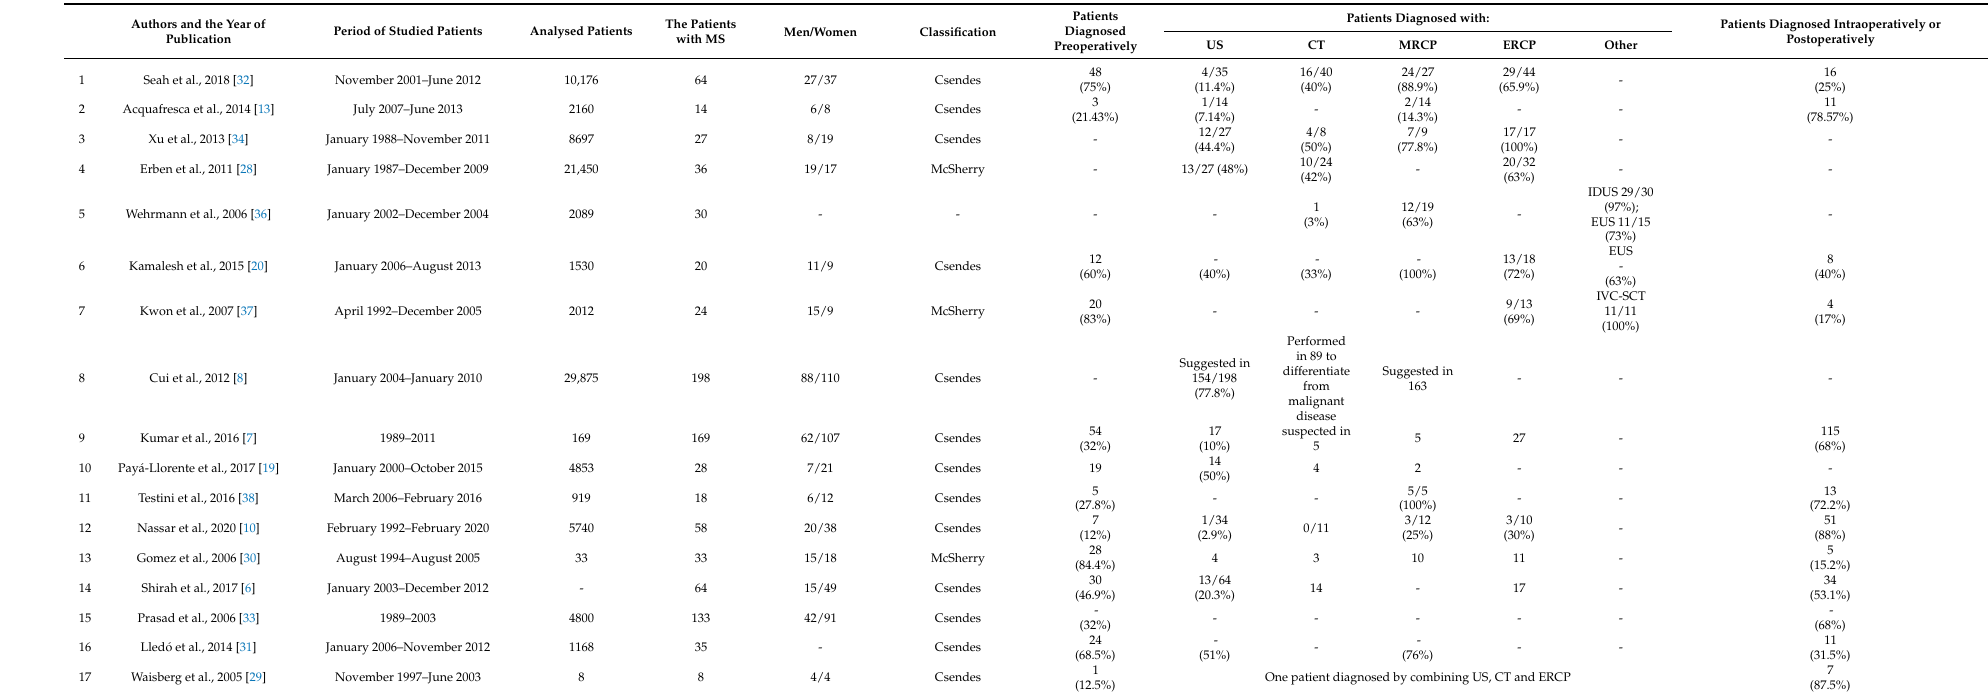
Table 2. Review studies of case series, arranged in order of concurrence in the ‘Imaging’ section of the